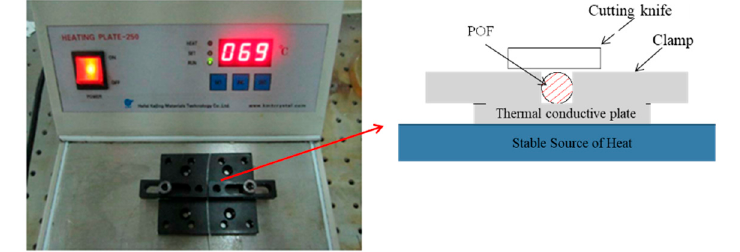
Figure 4. Equipment used for plastic optical fiber end cutting.